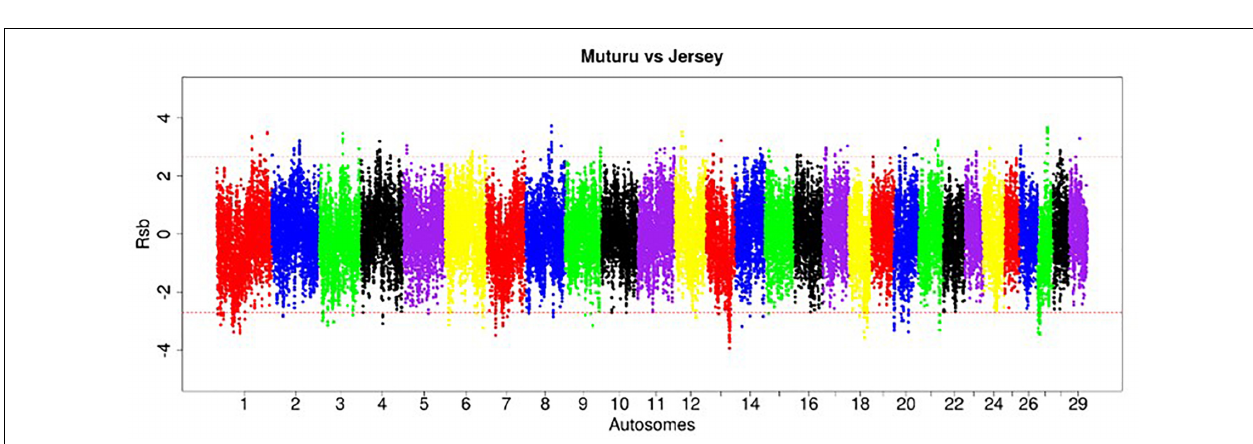
FIGURE 7 | Manhattan plot of the distribution of Rsb Muturu – Jersey. Red dash lines are the thresholds of the windows in the top 0.5% Rsb